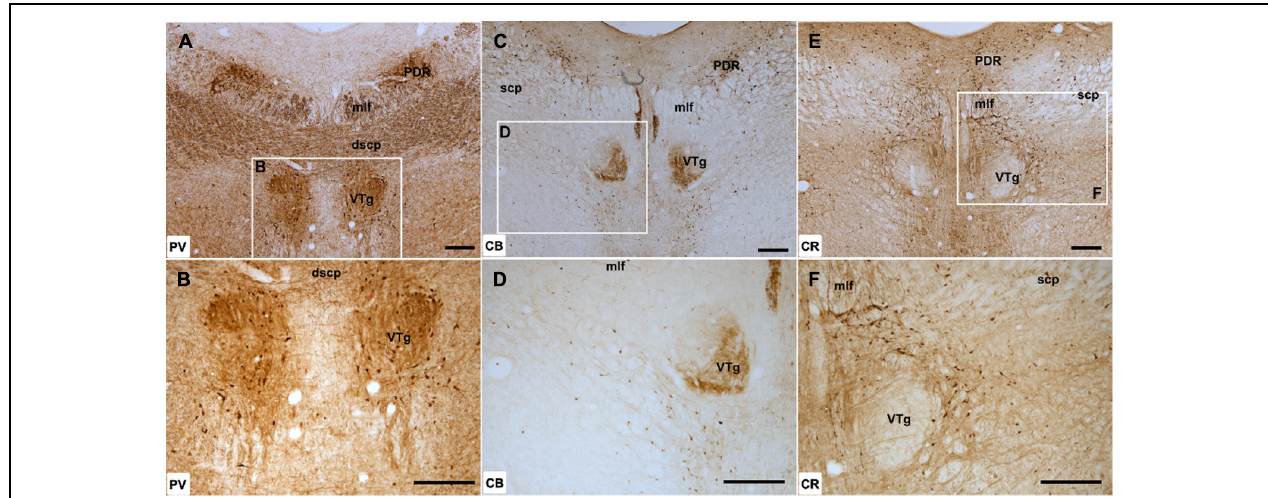
FIGURE 2 | Ventral tegmental nucleus of Gudden: (A,B) Low magnification (A; 50 × magnification) and higher magnification (B; 100 × magnification) photomicrographs of PV immunoreactivity in coronal sections of the rat midbrain. Dense PV label was present in the rostral part of the VTg but further caudally, an apparent boundary of neuropil immunoreactivity was present with more labels present in the lateral half of the nucleus. (C , D) Low ( C ; 50 × ) and high magnification ( D ; 100 × ) photomicrographs of CB